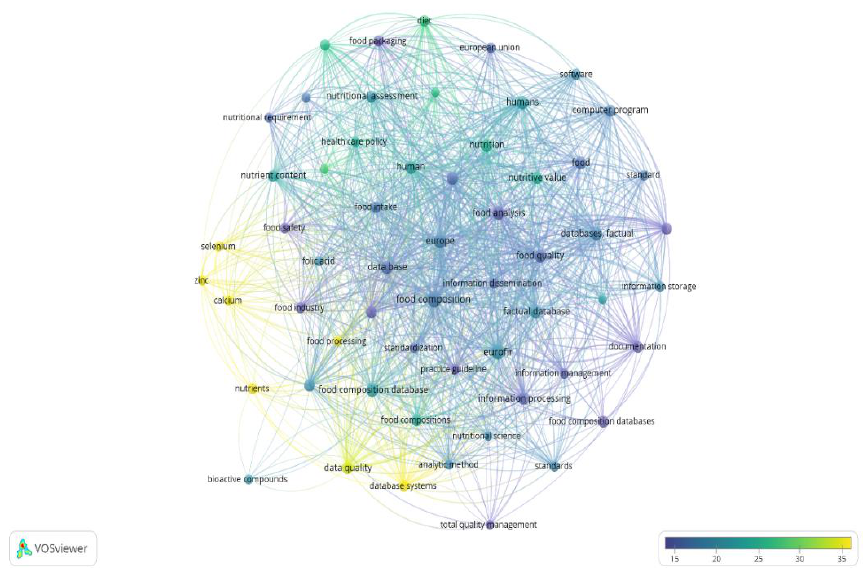
Figure 1. Term map for EuroFIR activities. Bubble size represents numbers of publications. Bubble color represents citations per publication (CPP). Bubbles are closer to one another if terms co-appeared more frequently (bibliometric data were extracted from Scopus and elaborated using VOSviewer software).